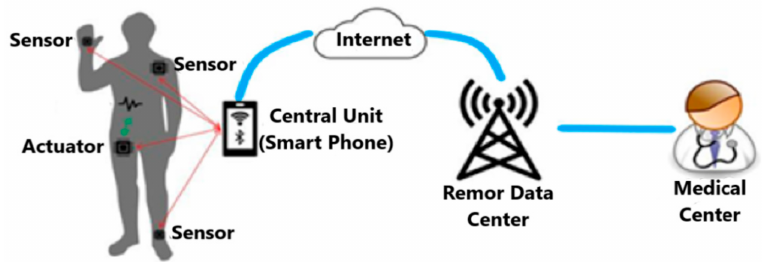
Figure 1. Wireless Body Area, adapted from